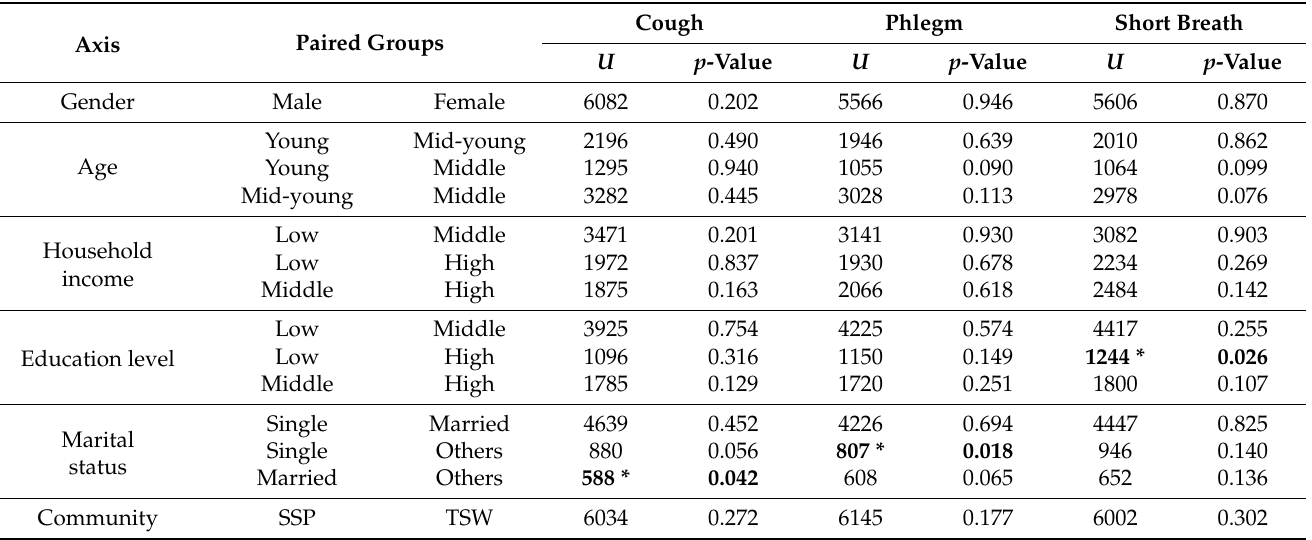
Table 3. Mann–Whitney U tests of difference in participants’ self-reported frequency of respiratory symptoms regarding different socio-demographic axes and geographic contexts.